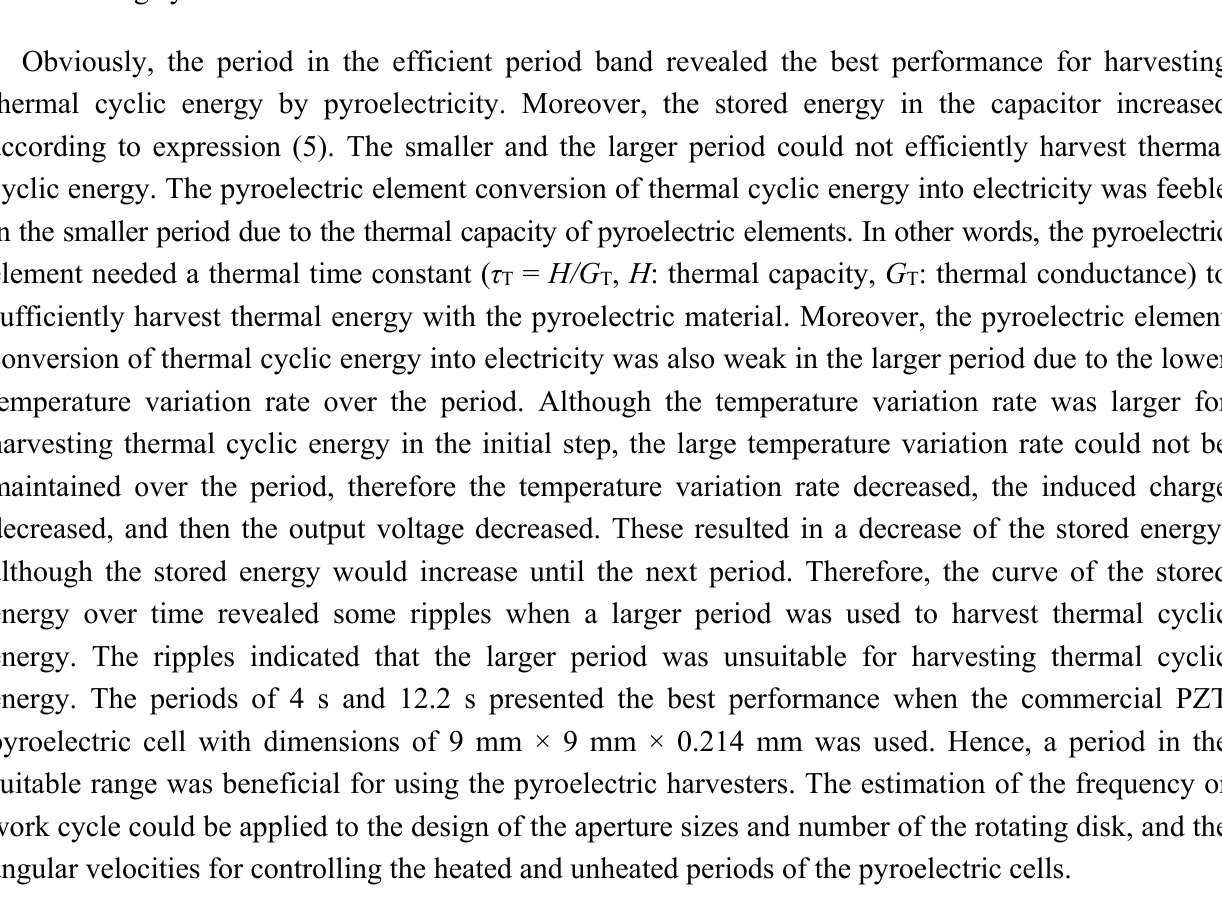
Figure 11. The stored energy over time at various periods during consecutive heating and cooling